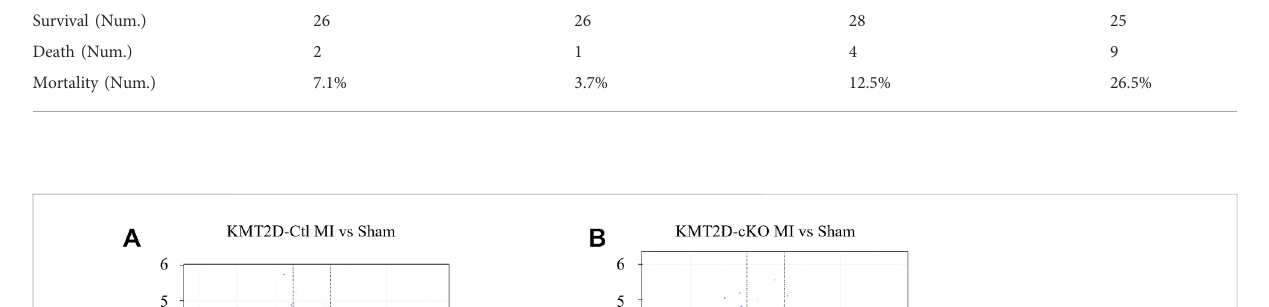
Total mice (Num.) 28 27 32 34 Survival (Num.) 26 26 28 25 Death (Num.) 2 1 4 9 Mortality (Num.)